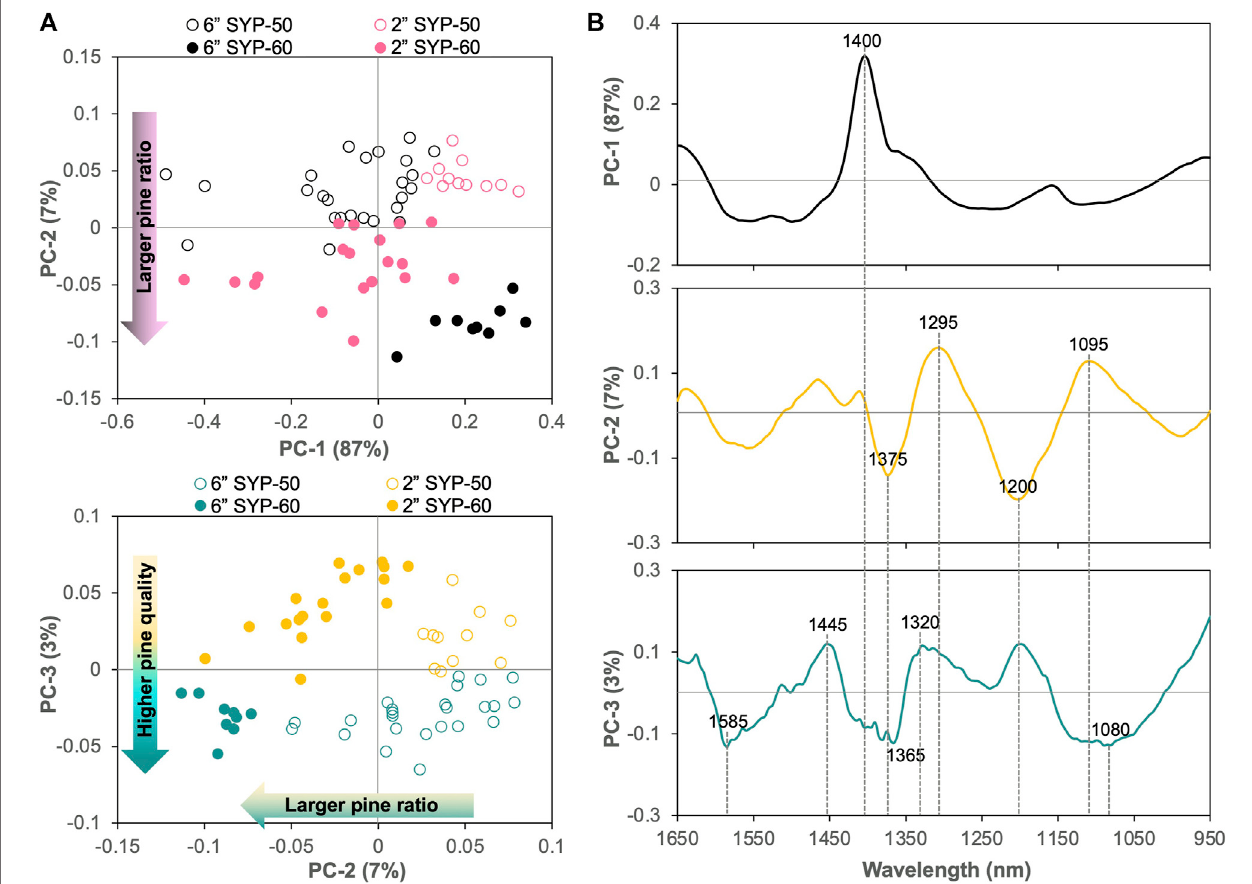
FIGURE4|(A) Scatterplotscomparingthescoresofprincipalcomponents(PC-)1,2,and3.Principalcomponentanalysis(PCA)wasconductedwithNIRspectra of blended southern yellow pine (SYP) and switchgrass (SG) pellets in the 950 – 1,650 nm region; (B) Line plots of principal component loadings corresponding to PC-1, PC-2, and PC-3. The pellet blends werecomposed of6-in.(152.4 mm) or2-in.(50.8 mm) SYPtops and SG, ground inahammer mill fi ttedwith a6.35 mm screen, and mixed at either 60:40 or 50:50 ratio.